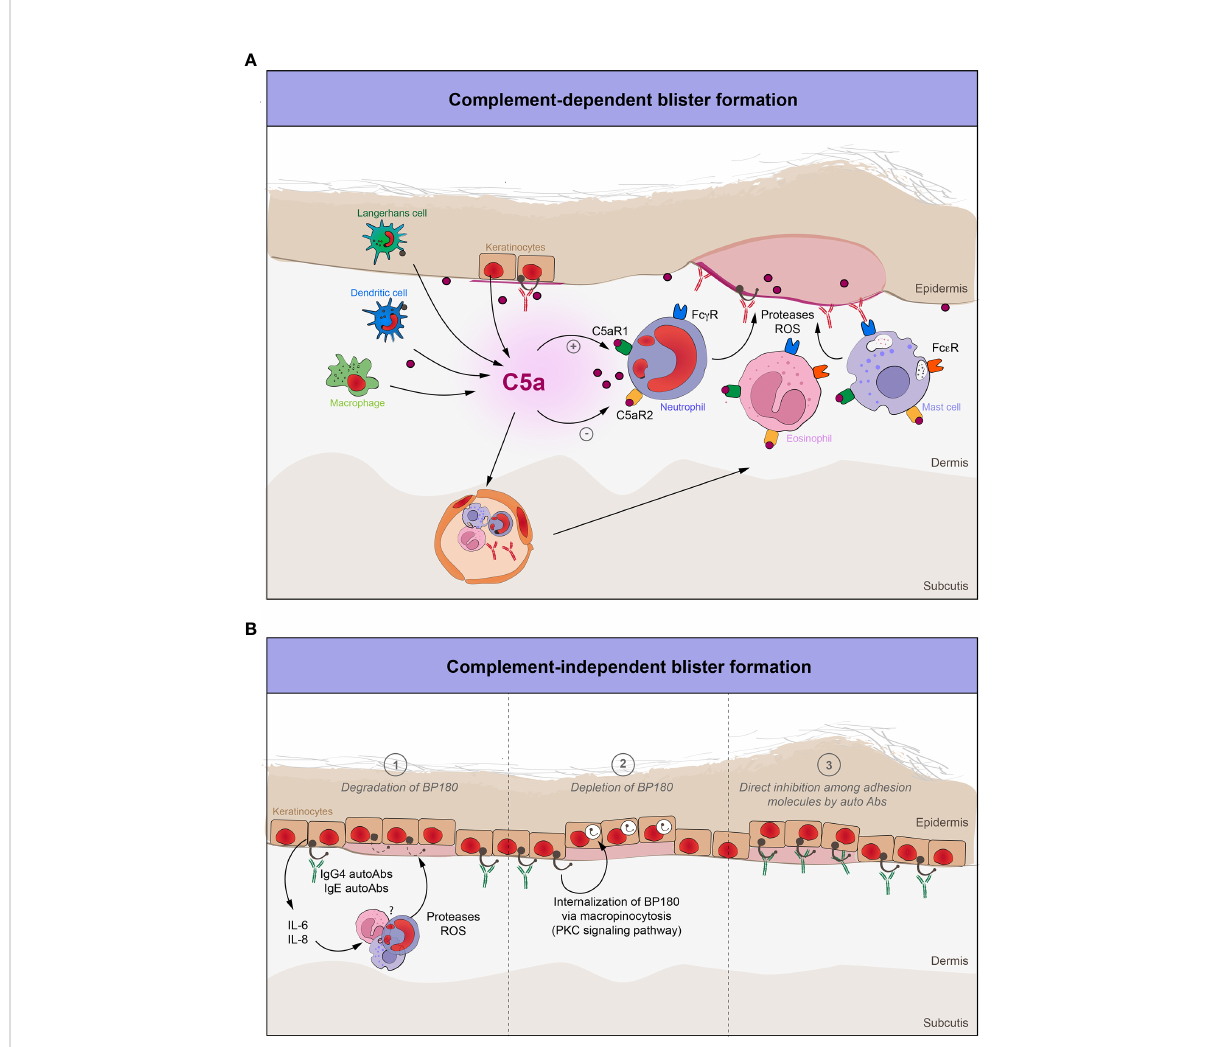
FIGURE 2 The role of complement in blister formation in pemphigoid diseases. (A) Complement-dependent pathways in pemphigoid diseases. Complement- fi xing autoantibodies target various structural antigens of the basement membrane. The complement system is activated, thus leading to the recruitment and activation of various effector cells. C5a, which is the most potent proin fl ammatory peptide of the complement cascade, will interact with these cells through their C5a receptors (C5aR1, C5aR2), enabling them to release several proteases and ROS, thereby in fl icting tissue damage and characteristic subepidermal blistering. (B) Complement-independent pathways in pemphigoid diseases. Non- complement fi xing autoantibodies (IgG4) and IgE against BP180 bind to the dermal-epidermal junction and (1) degrade BP180 by increasing the expression of IL-6 and IL-8, which in turn will attract and activate neutrophils, as a major source of various proteases and ROS; (2) decrease the BP180 hemidesmosomal content by internalization of the IgG-BP180 immune complex via macropinocytosis; (3) directly inhibit the adhesion molecules of the dermal-epidermal